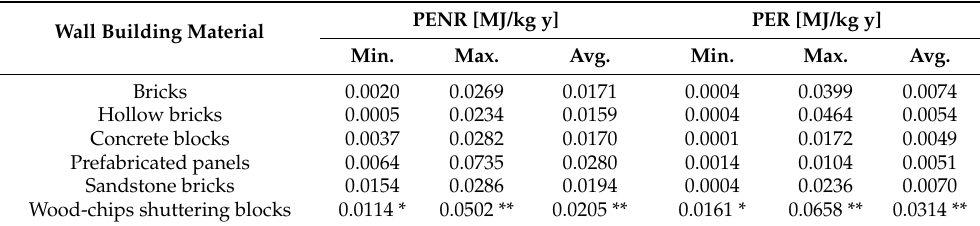
Table 7. Minimum, maximum, and average values of PENR and PER normalized for the service life. Stages A1–A3 were considered for all the products analyzed. In addition, if data were available, stage A5 was considered for the shuttering block.